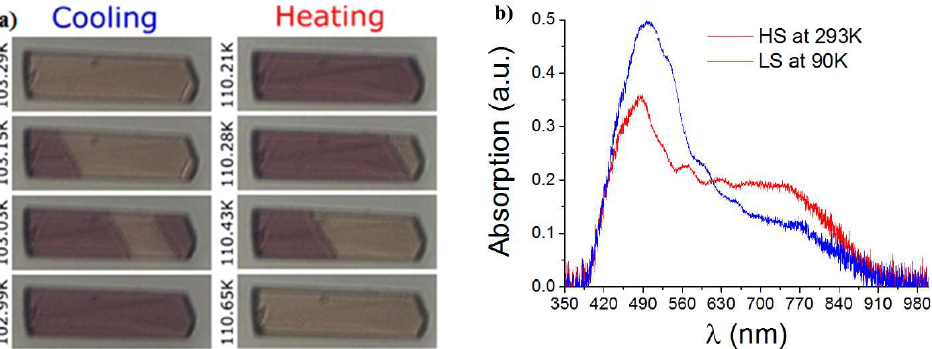
Figure 4. ( a ) Selected optical microscopy (OM) snapshots on cooling and heating showing the experimental spatiotemporal behavior of [{Fe(NCSe)(py) 2 } 2 (m-bpypz)] single crystal along the spin transition, recorded at a scan rate of 𝑟 = 0.2 K min −1 and light intensity of 𝐼 = 21 mW cm −2 . The dark (respectively light) phase corresponds to the LS (respectively HS) state. ( b ) Optical spectra of the current single crystal recorded in the LS (blue) and HS (red) states, showing absorption bands in the visible region.